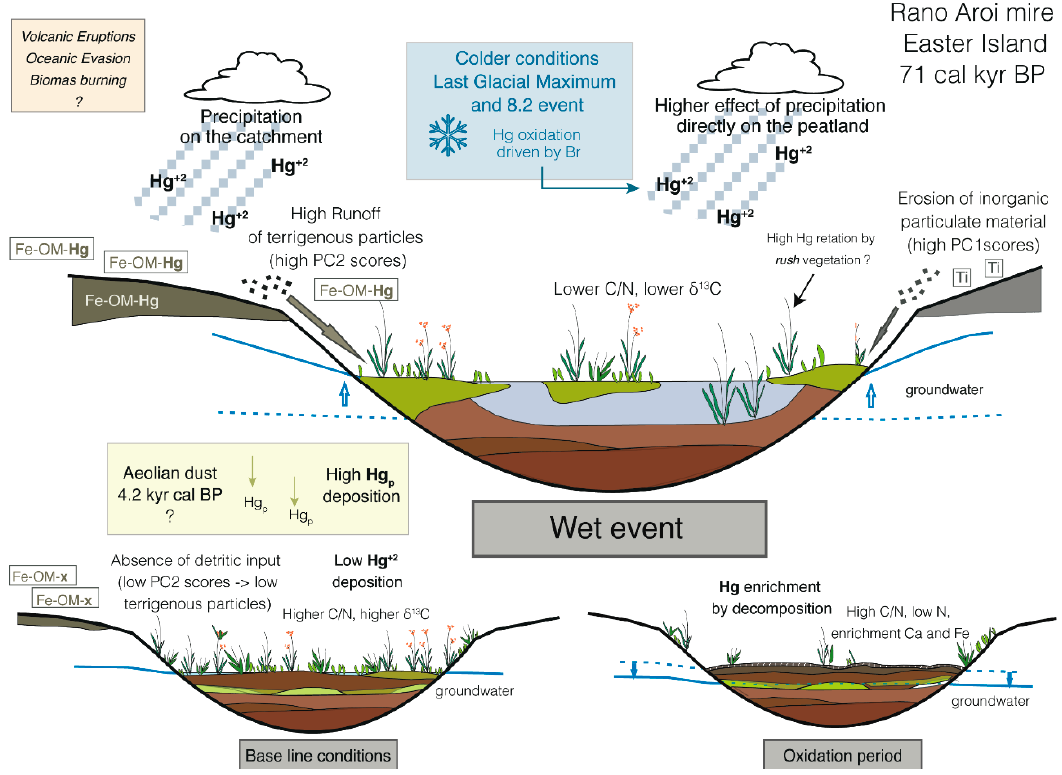
Figure 6. Mire schematic model indicating the processes controlling Hg deposition and accumulation under different environmental conditions. During rainfall events, Hg accumulates via wet deposition directly to the mire or through catchment soils. In baseline conditions the Hg accumulation is low. Under the dry peatland stage (i.e., ca. 40.0–42.0 ka cal BP) the peat-organic matter decomposition increases Hg content. The effect of vegetation and volcanic activity is not well addressed in this study. Modified from previous research [31].